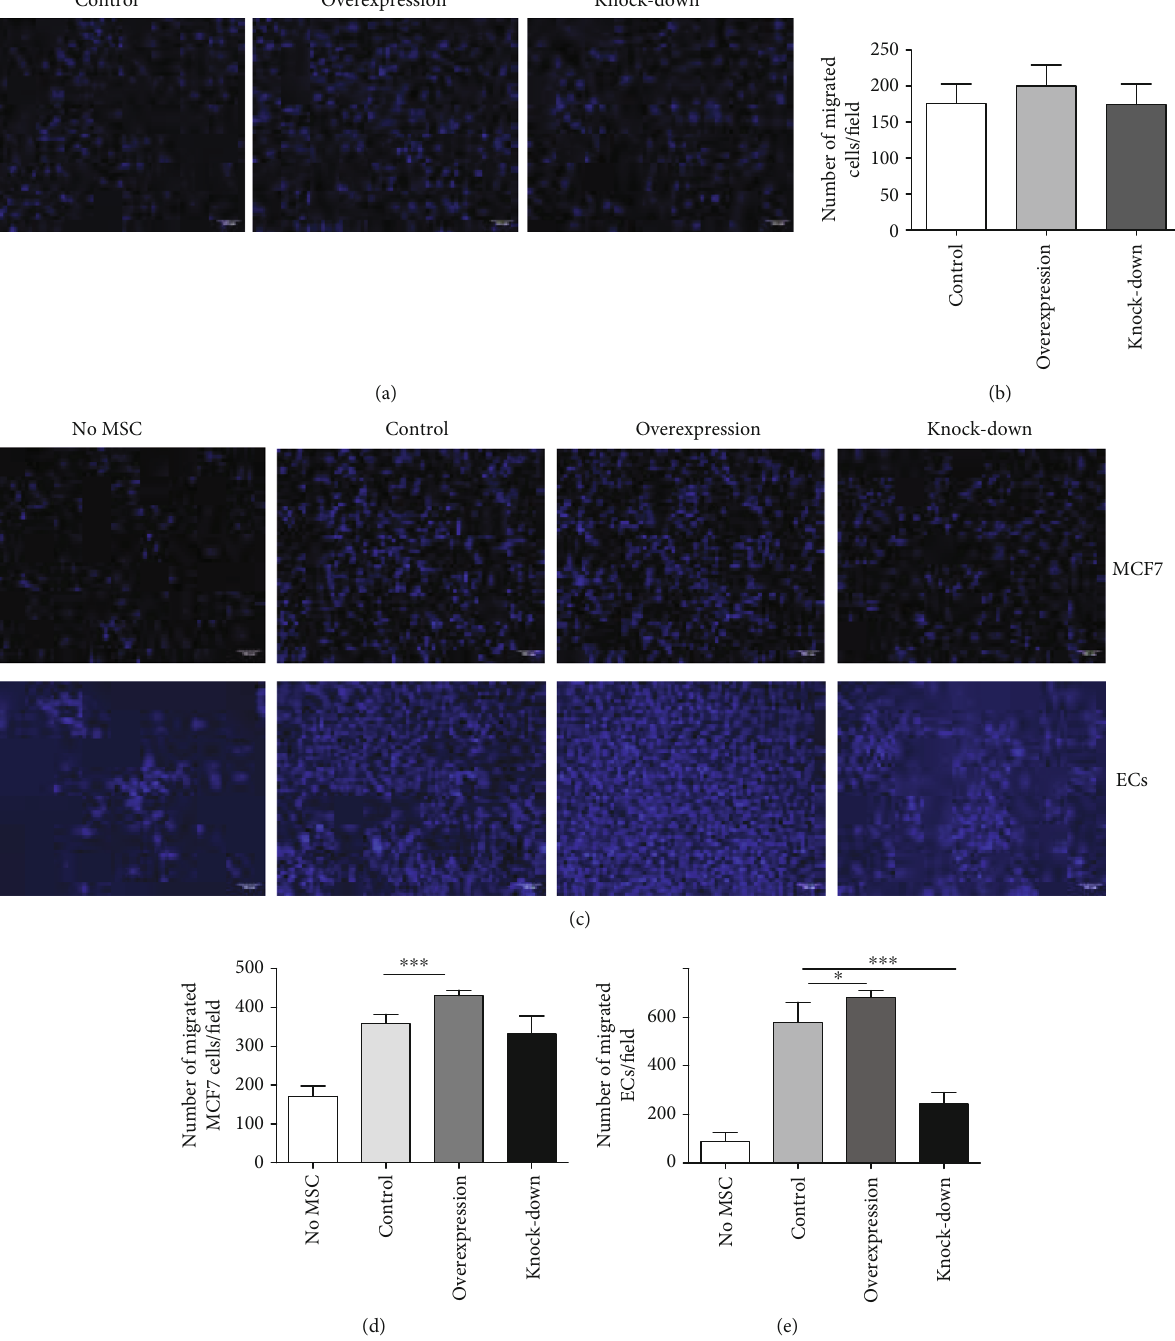
Figure 9: Migration potential and recruitment capability of di ff erent groups of BM-MSCs. (a – b) Migration level of di ff erent groups of BM- MSCs assessed by transwell assay. Scale bar = 100 μ m . (c – e) Migration level of MCF7 cells and ECs cocultured with di ff erent groups of BM- MSCs in a chemotaxis transwell system. All experiments were repeated at least three times. Data are presented as mean ± SD . ∗ p < 0 : 05 , ∗∗∗ p < 0 : 001 . Scale bar = 100 μ m